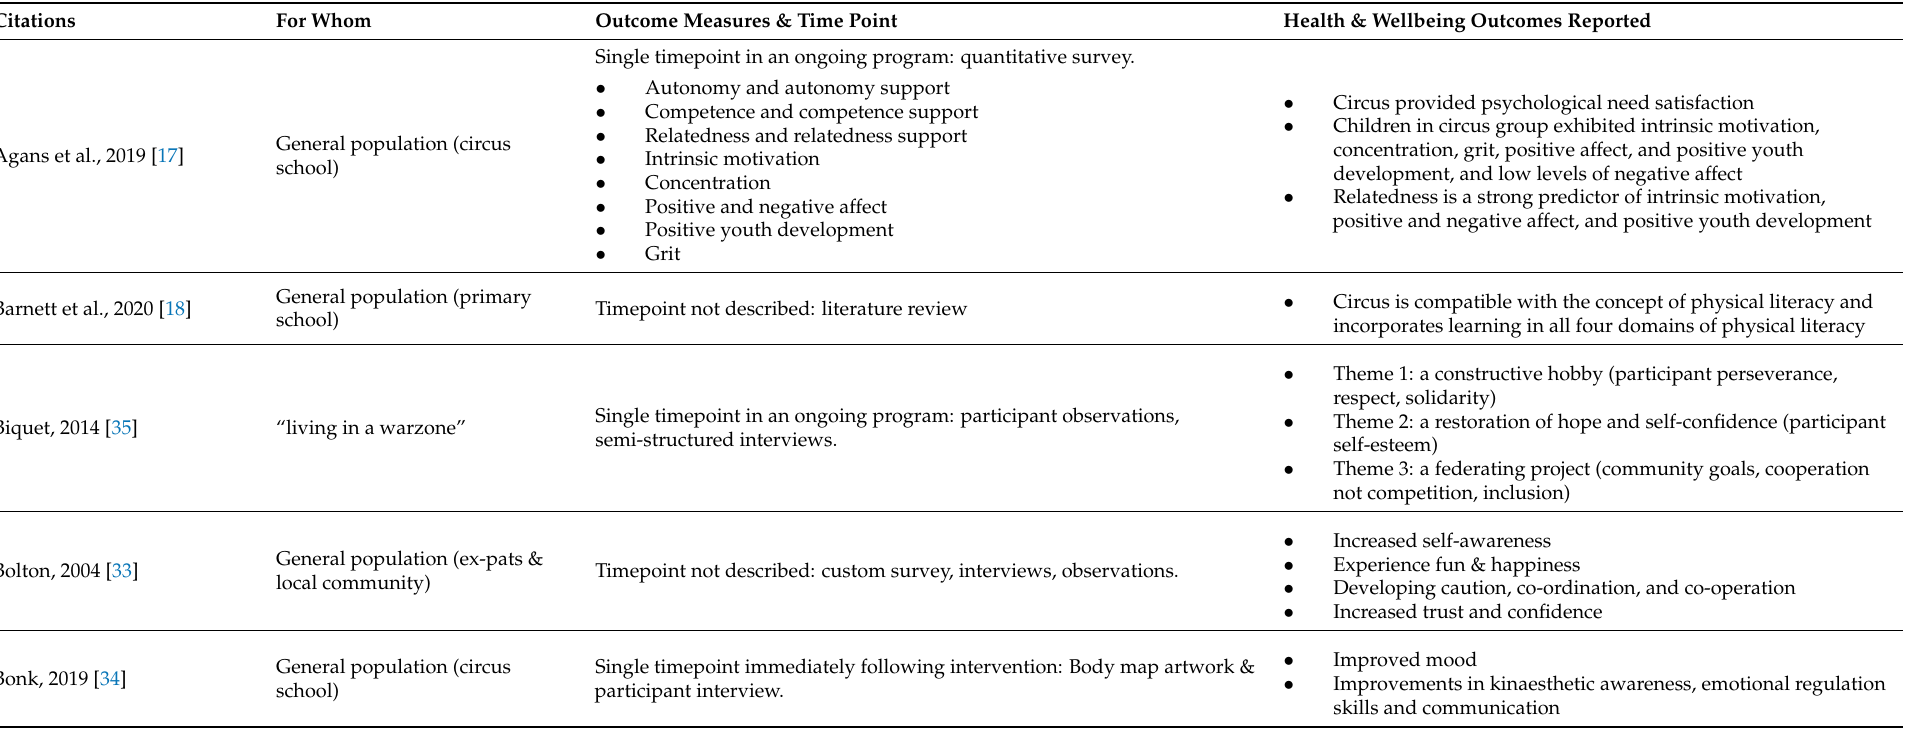
Table A6. Health & wellbeing outcomes and